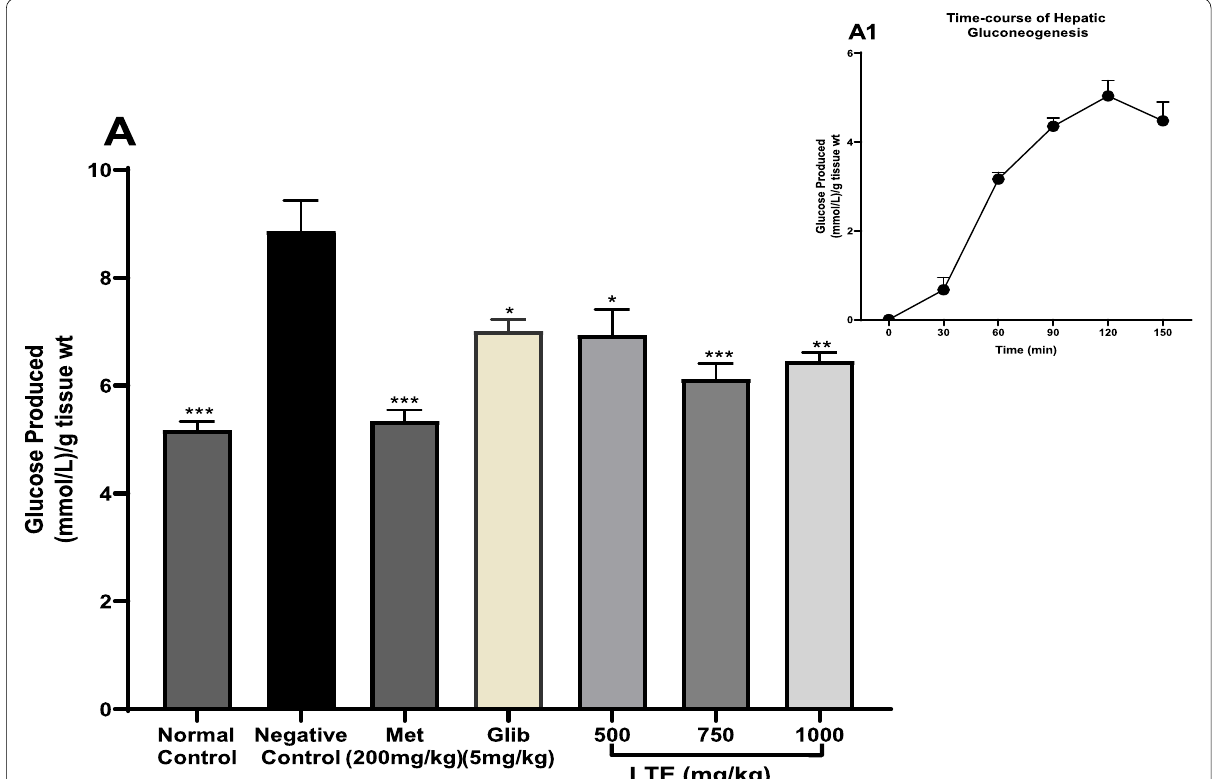
Fig. 8 Time‑course of hepatic glucose production (8A1) vs. gluconeogenesis at time 120 minutes ( A ). Values were expressed as mean Data were analyzed using one‑way ANOVA followed by Dunnett’s multiple comparisons test. * represents statistical significance at p < 0.05 vs. the negative control